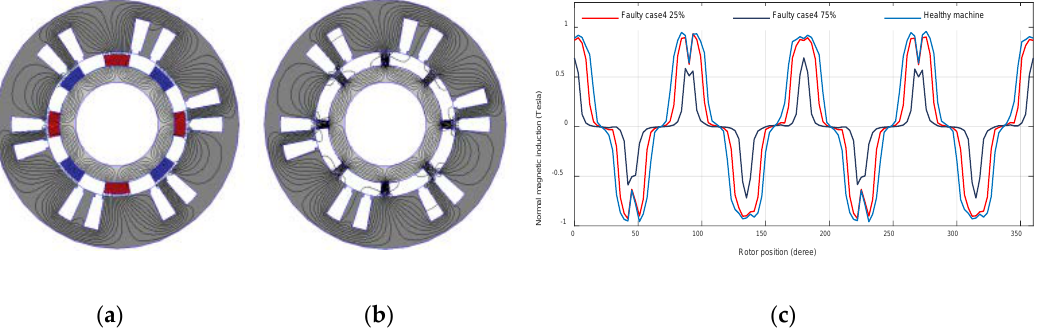
Figure 9. Faulty case 4: ( a ) Magnetic field under 25%; ( b ) magnetic field under 75%; ( c ) airgap magnetic flux density.